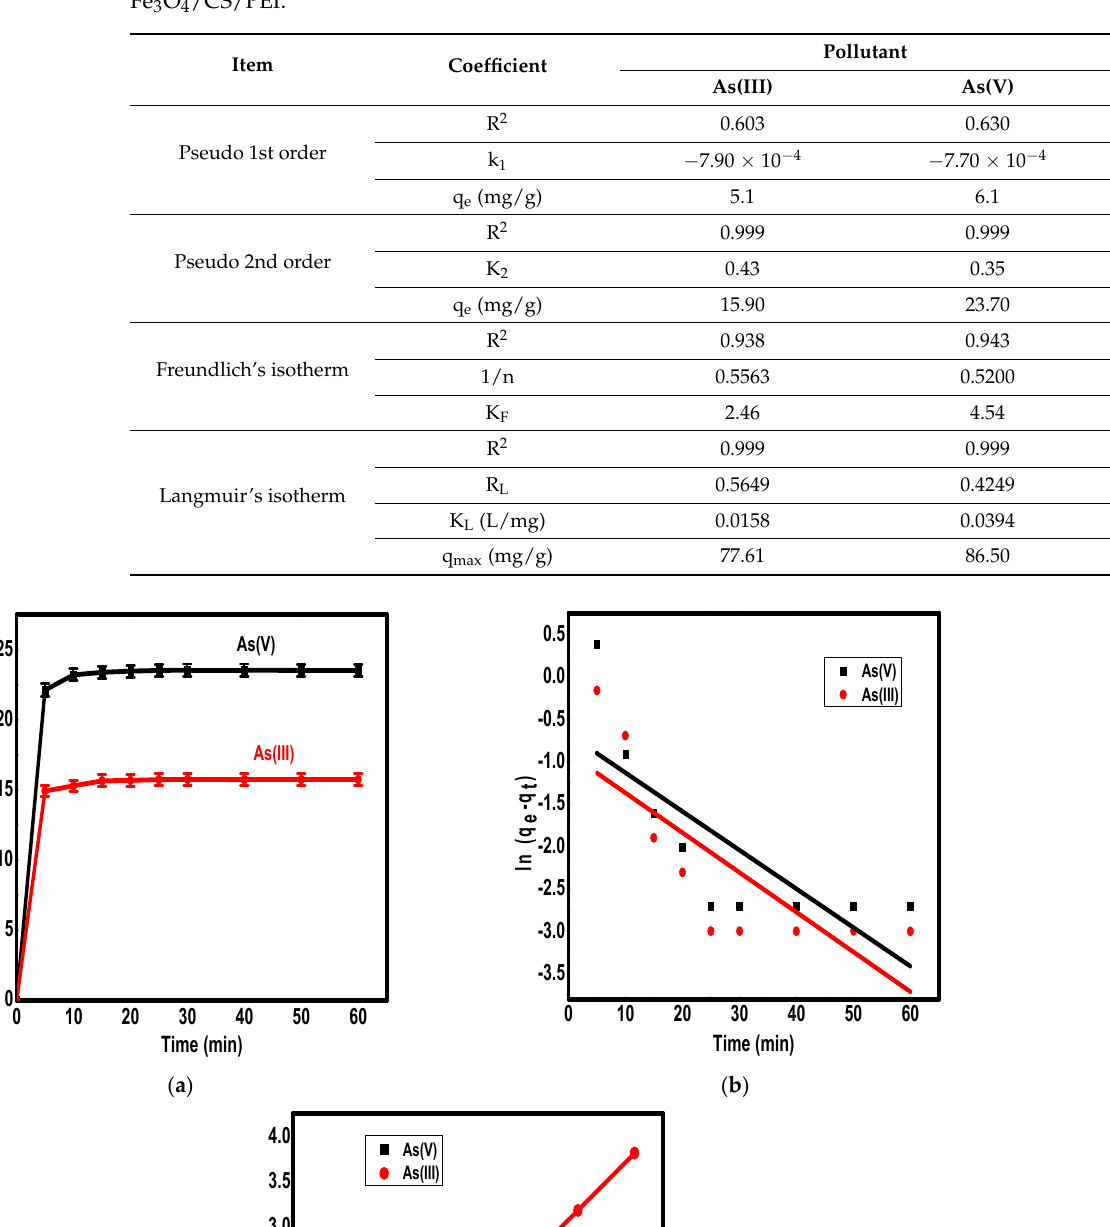
Table 1. Kinetic parameters for the uptake of arsenic ions over the studied magnetic nanocomposite Fe 3 O 4 /CS/PEI.